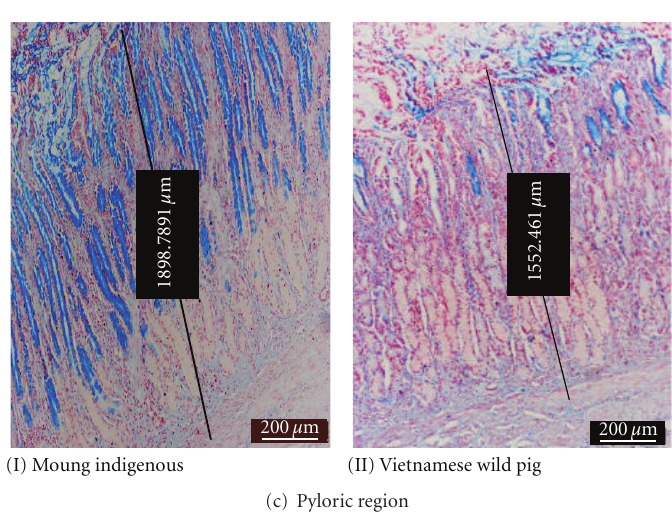
Figure 6: Photomicrograph of AB staining showing di ff erent a ffi nity of positive areas at various